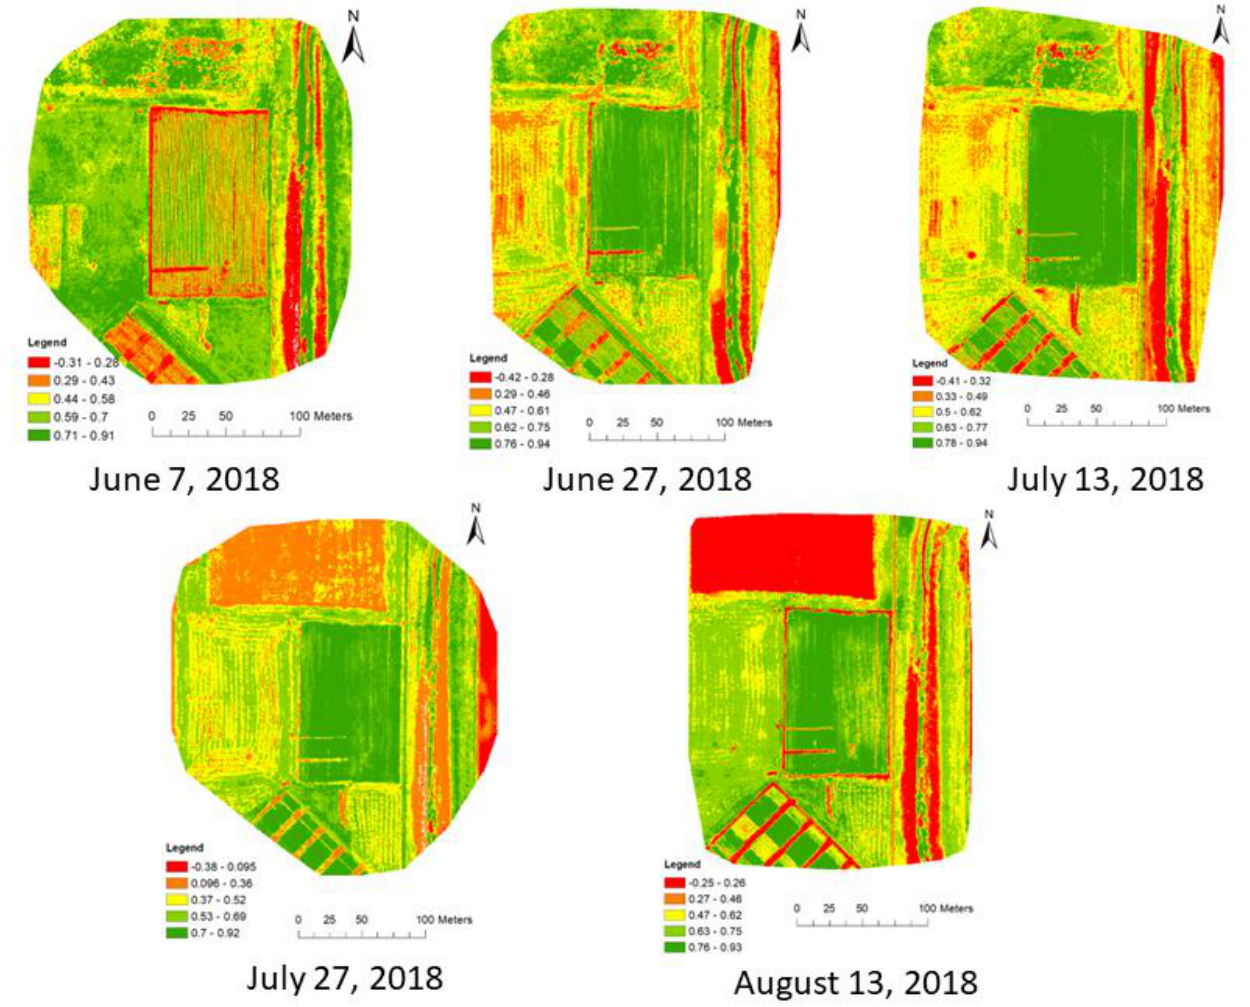
Figure 7. UAV NDVI images of the soybean field in the research farm area at Brooksville, Mississippi in 2018.